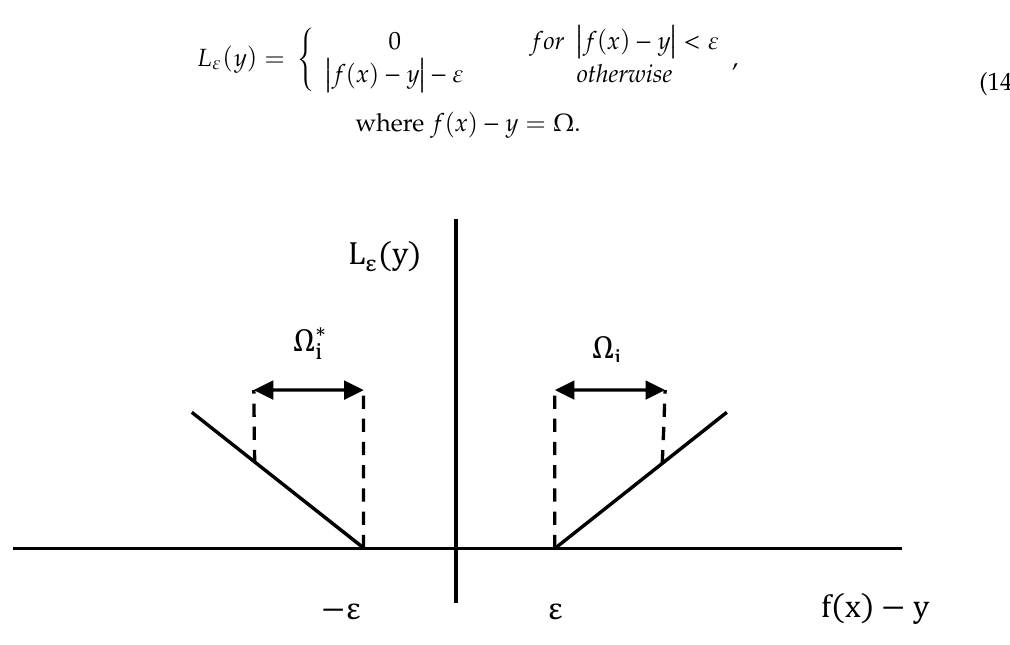
Figure 8. ε -insensitive loss Figure 8. (cid:2013) -insensitive loss function.